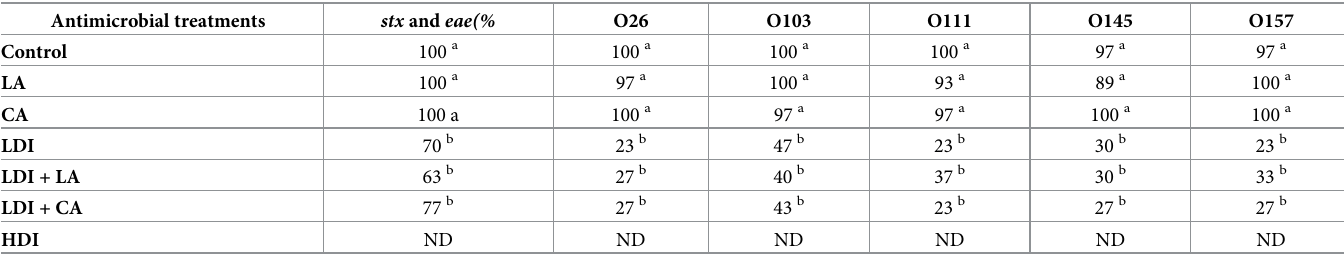
a, b Interventions with no common letter are significantly different ( P < 0.05) using Generalized Lineal Model. LA, lactic acid (0.5%); CA, caprylic acid (0.04%); LDI, low-dose irradiation (0.5 kGy); HDI, high-dose irradiation (2 kGy). ND: not